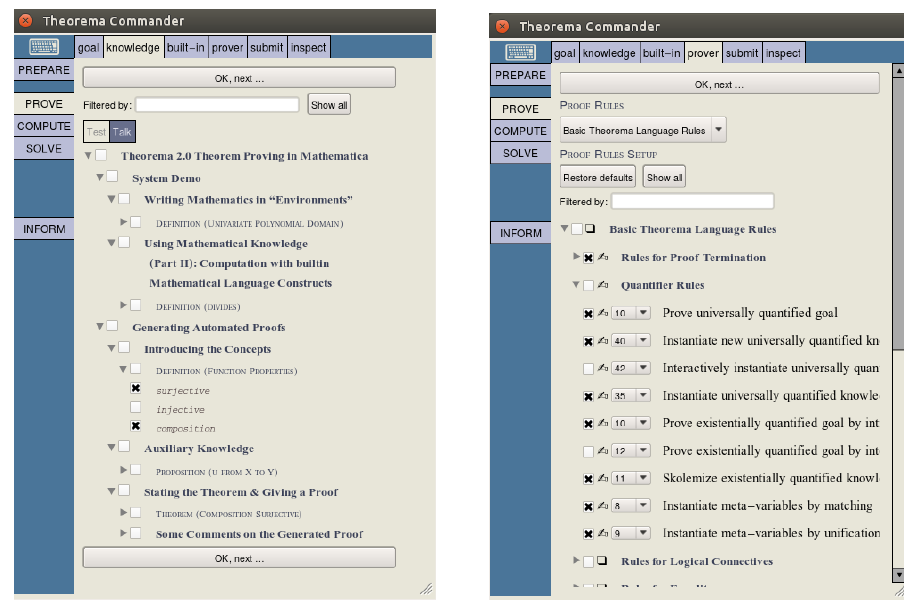
Fig. 3. The knowledge browser (left) and the prover configuration